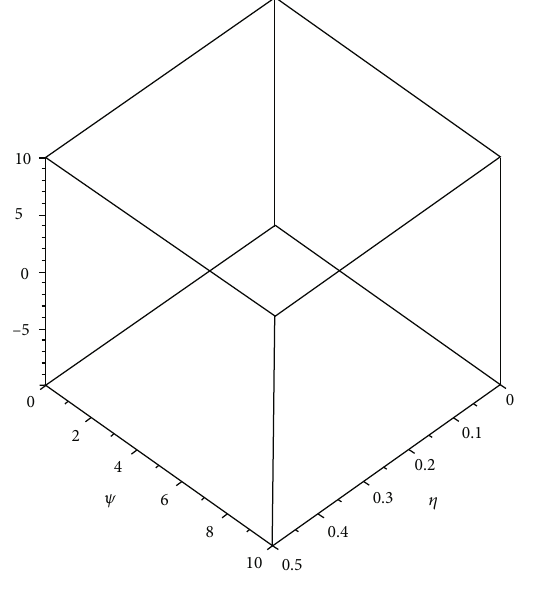
Figure 3: The fi rst graph shows the fuzzy 3D upper and lower fi gure of the various fractional orders of γ